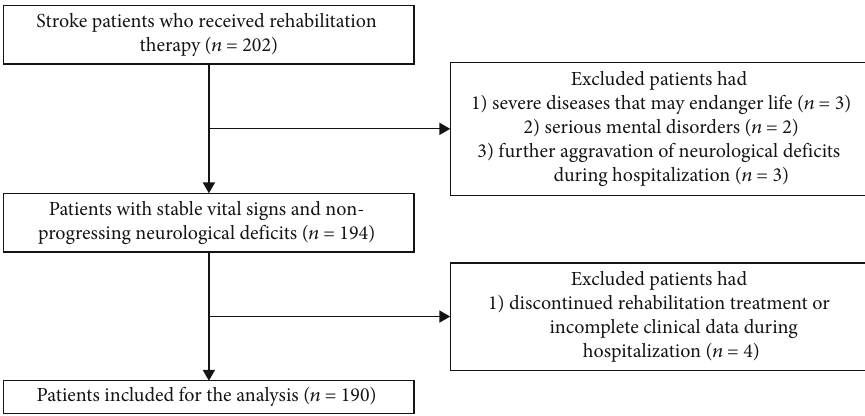
Figure 1: Study fl owchart. Table 1: Comparison of the rehabilitation therapies between patients with a BI score < 60 and ≥ 60 at discharge. BI score < 60 at